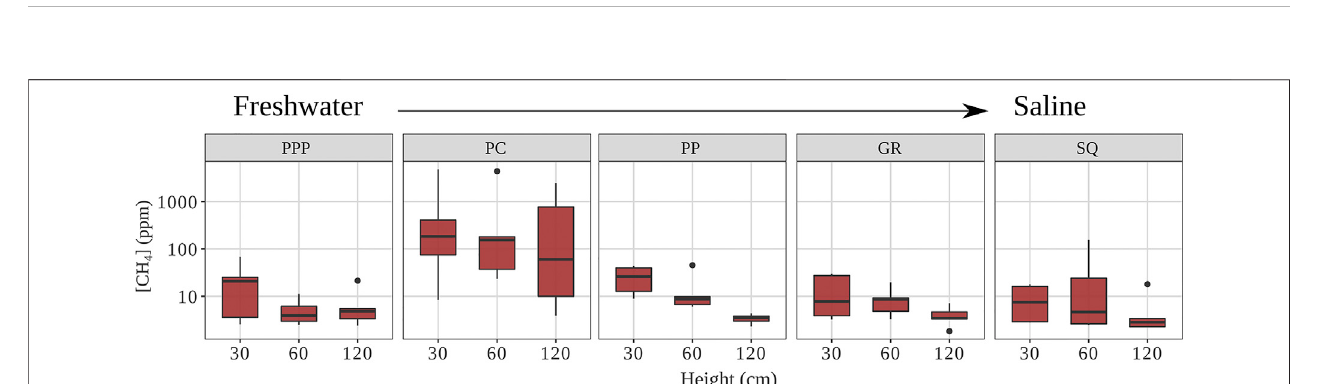
FIGURE 2 | Heartwood CH 4 concentrations for each site (from fresh to saline) and height (PPP — Palmetto Peartree, PC — Pocosin Lakes, PP — Point Peter, GR — Gull Rock, and SQ — Swanquarter). Solid line represents median, whiskers represent 5th and 95th percentiles, and dots are outliers (Note: y -axis is log scaled).